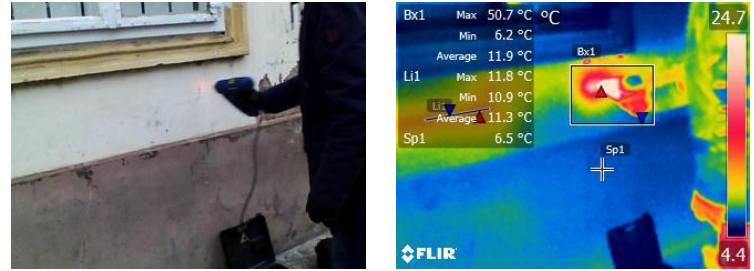
Figure 19. Initial application moment of thermal excitation.